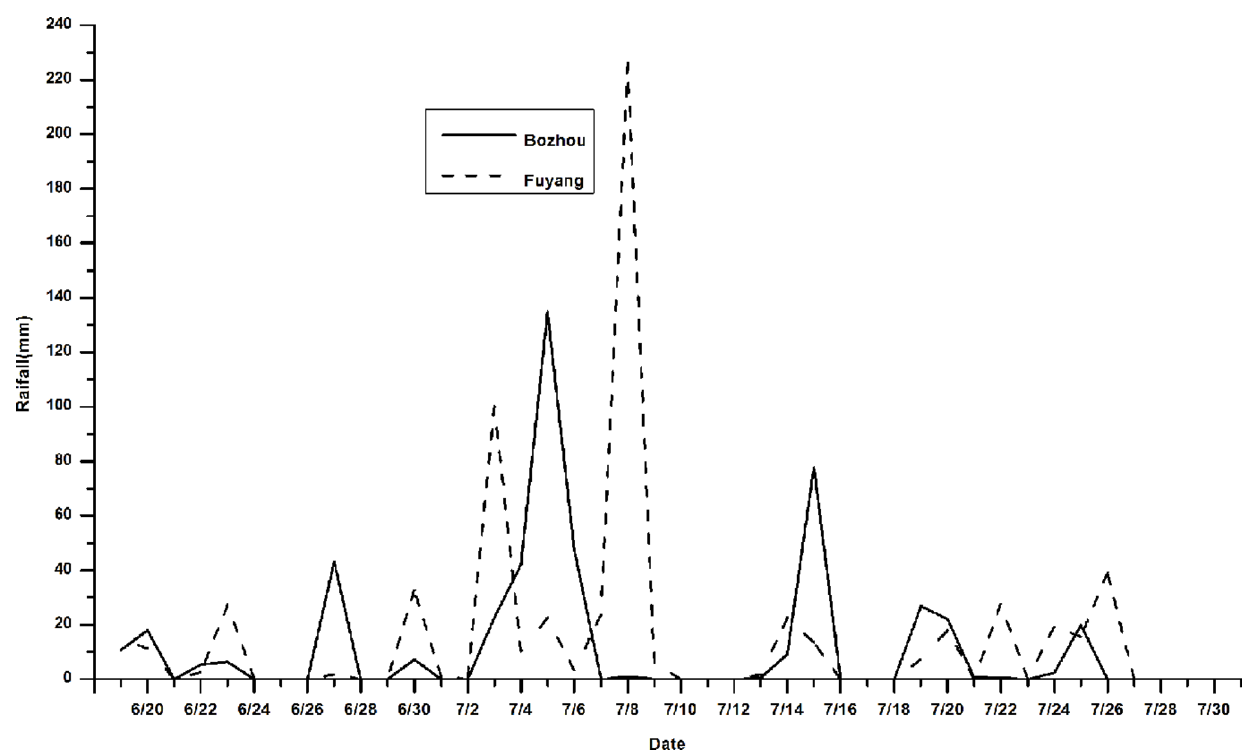
Figure 2. Daily rainfalls in Fuyang and Bozhou during the Meiyu-flood-season, 2007.